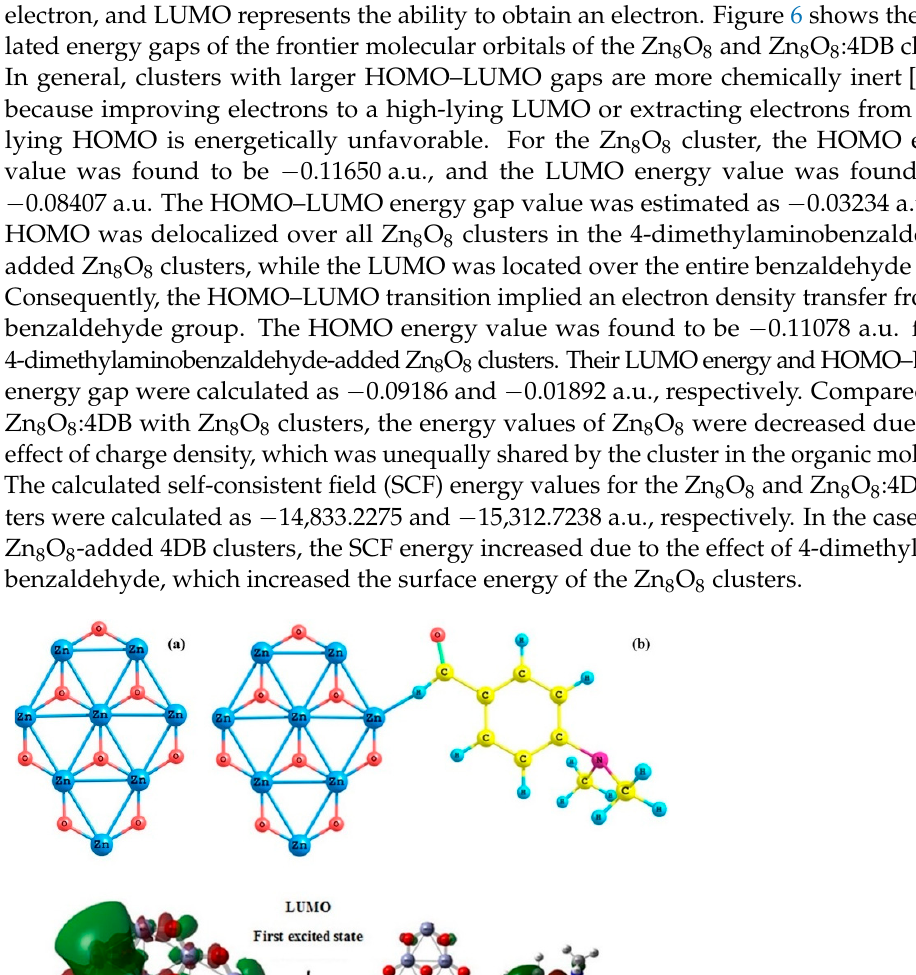
Figure 5. Photoluminescent properties of the ( a ) ZnO NPs and ( b ) 4DB:ZnO NPs.